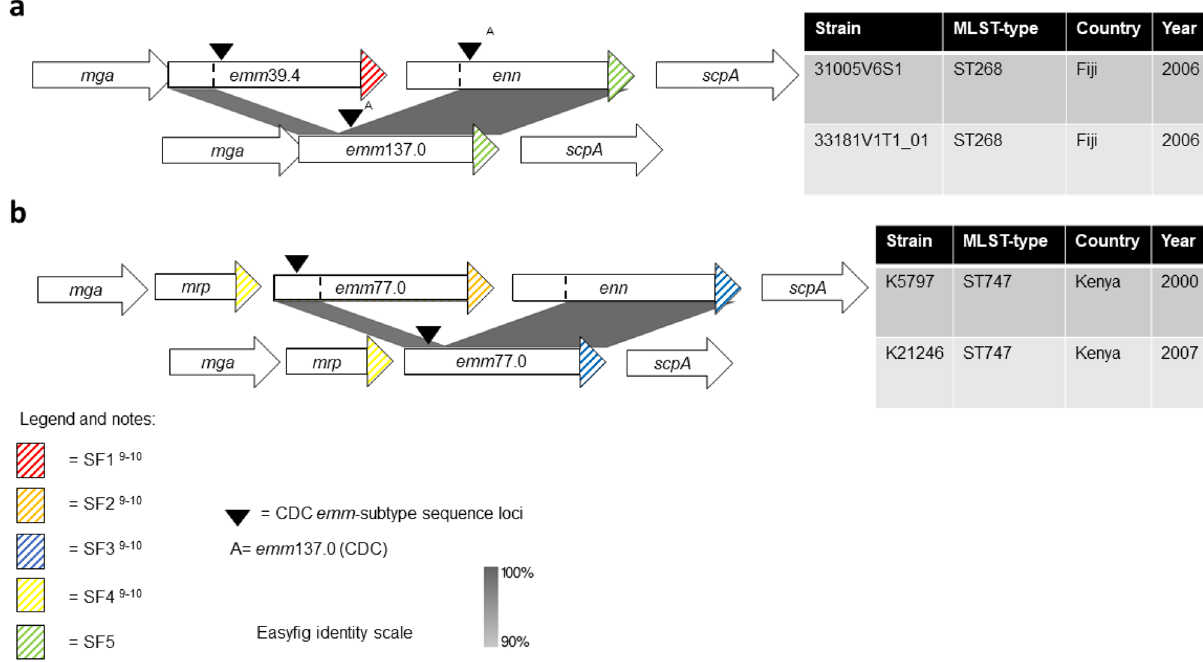
Figure 4. Evolutionary pathways of two novel chimeric emm - enn events in the mga regulon of GAS. ( a ) ‘Contrariwise’ and ( b ) ‘Likewise’ events are depicted were the mutated isolate changes its emm -subtype, and retains its emm -subtype, respectively. The chimeric emm - enn is represented by a deletion-fusion event that culminates in a new gene containing the 5 ′ end of emm and the 3 ′ end of enn .